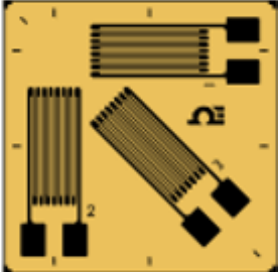
Figure 28. Measured output voltage (Vout) for a 7.5 cm length cantilever beam with three piezoelectric sensors, as shown in Figure 13. Three samples were applied for each test (length and frequency). Small black numbers, accumulated voltage measurements.